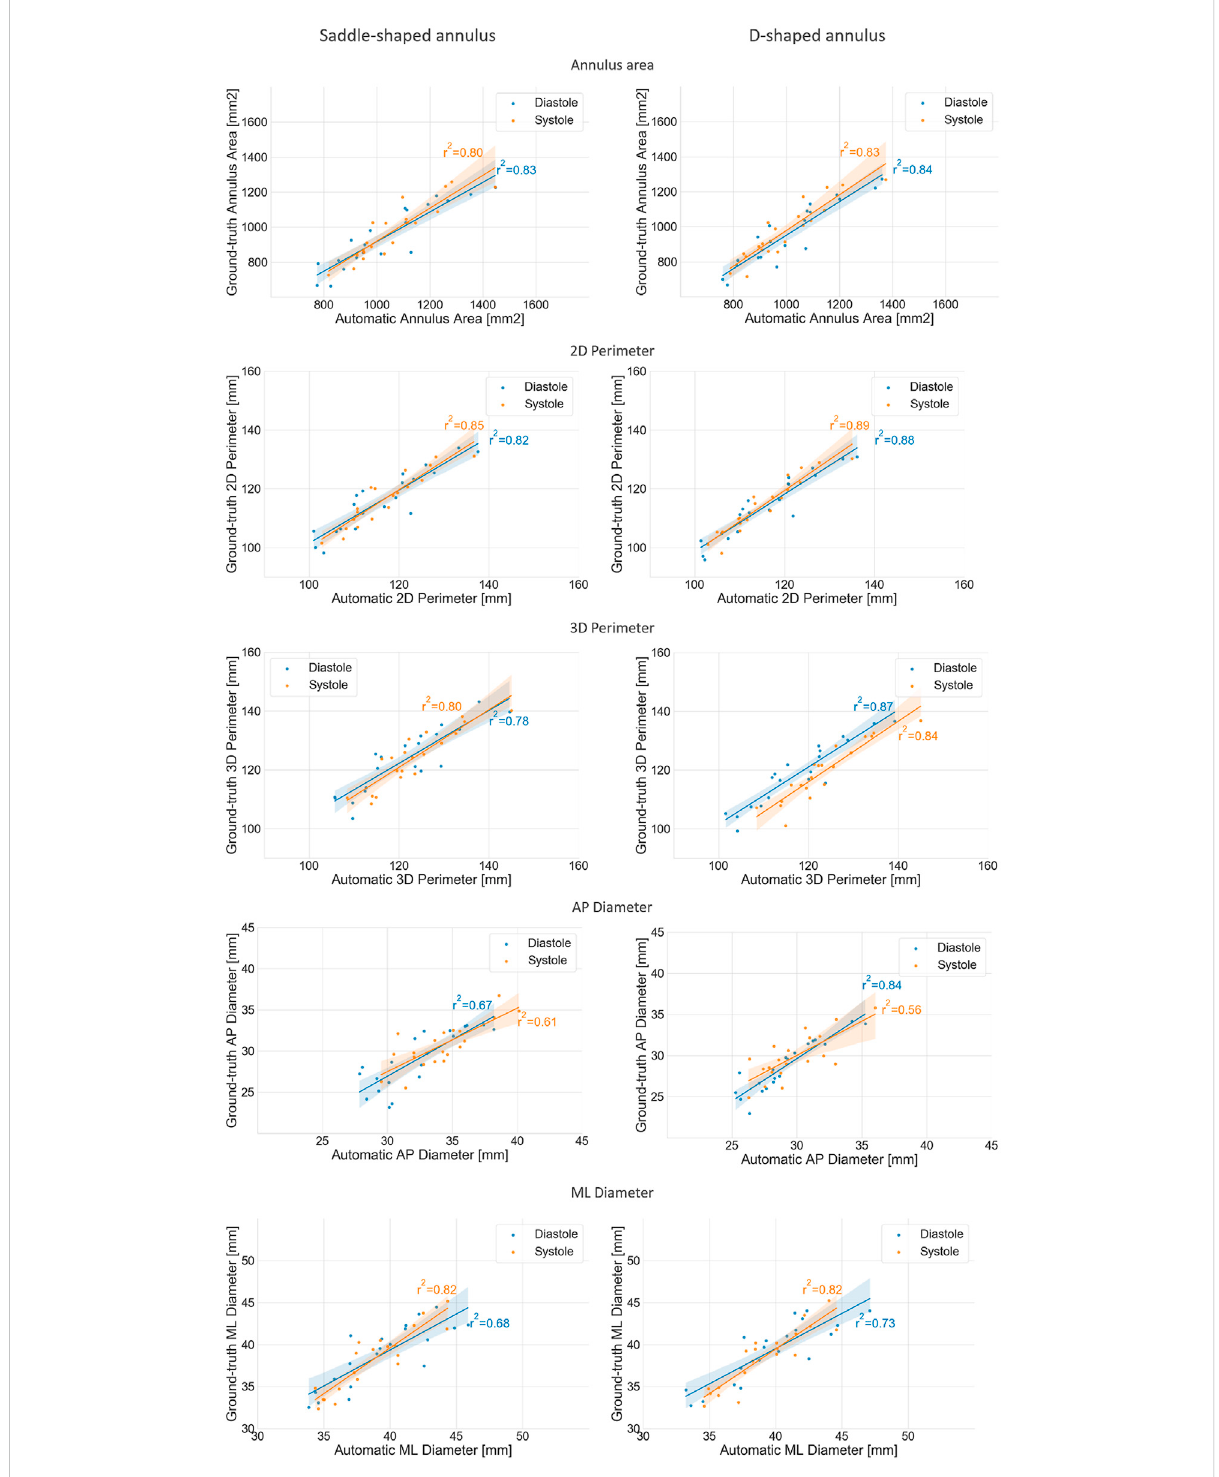
FIGURE 7 Regression plots comparing the mean annulus measurements obtained for the three observers and those calculated from the automatically detected landmarks, for both the saddle- (left) and D-shaped (right) con fi